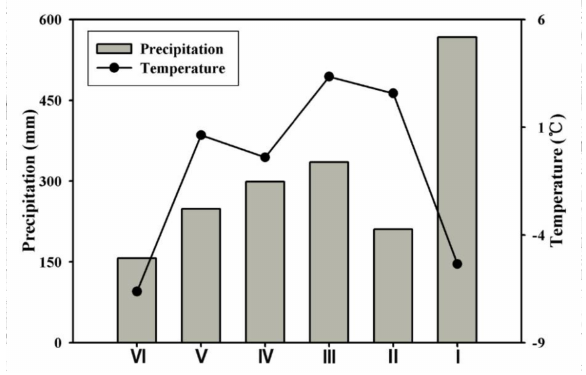
Figure 3. Mean annual precipitation (AP, mm) and annual mean temperature (AMT, ◦ C) of the six regions for the period of 1971–2015.